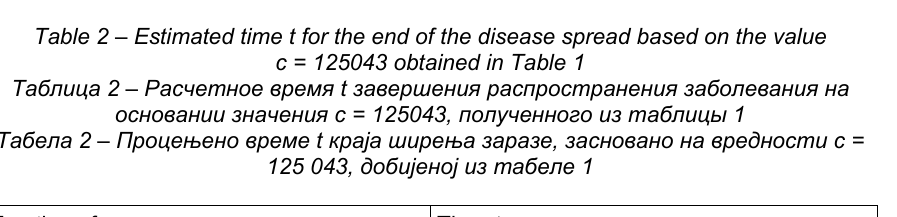
224 Table 2 – Estimated time t for the end of the disease spread based on the value